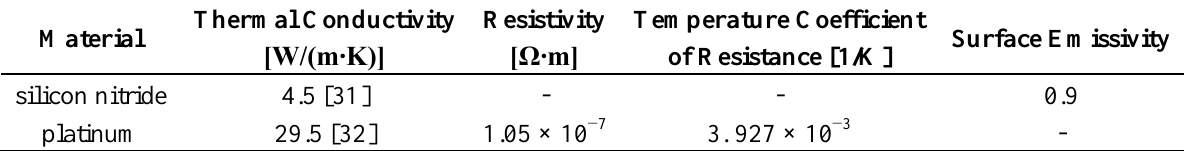
Table 1. Material